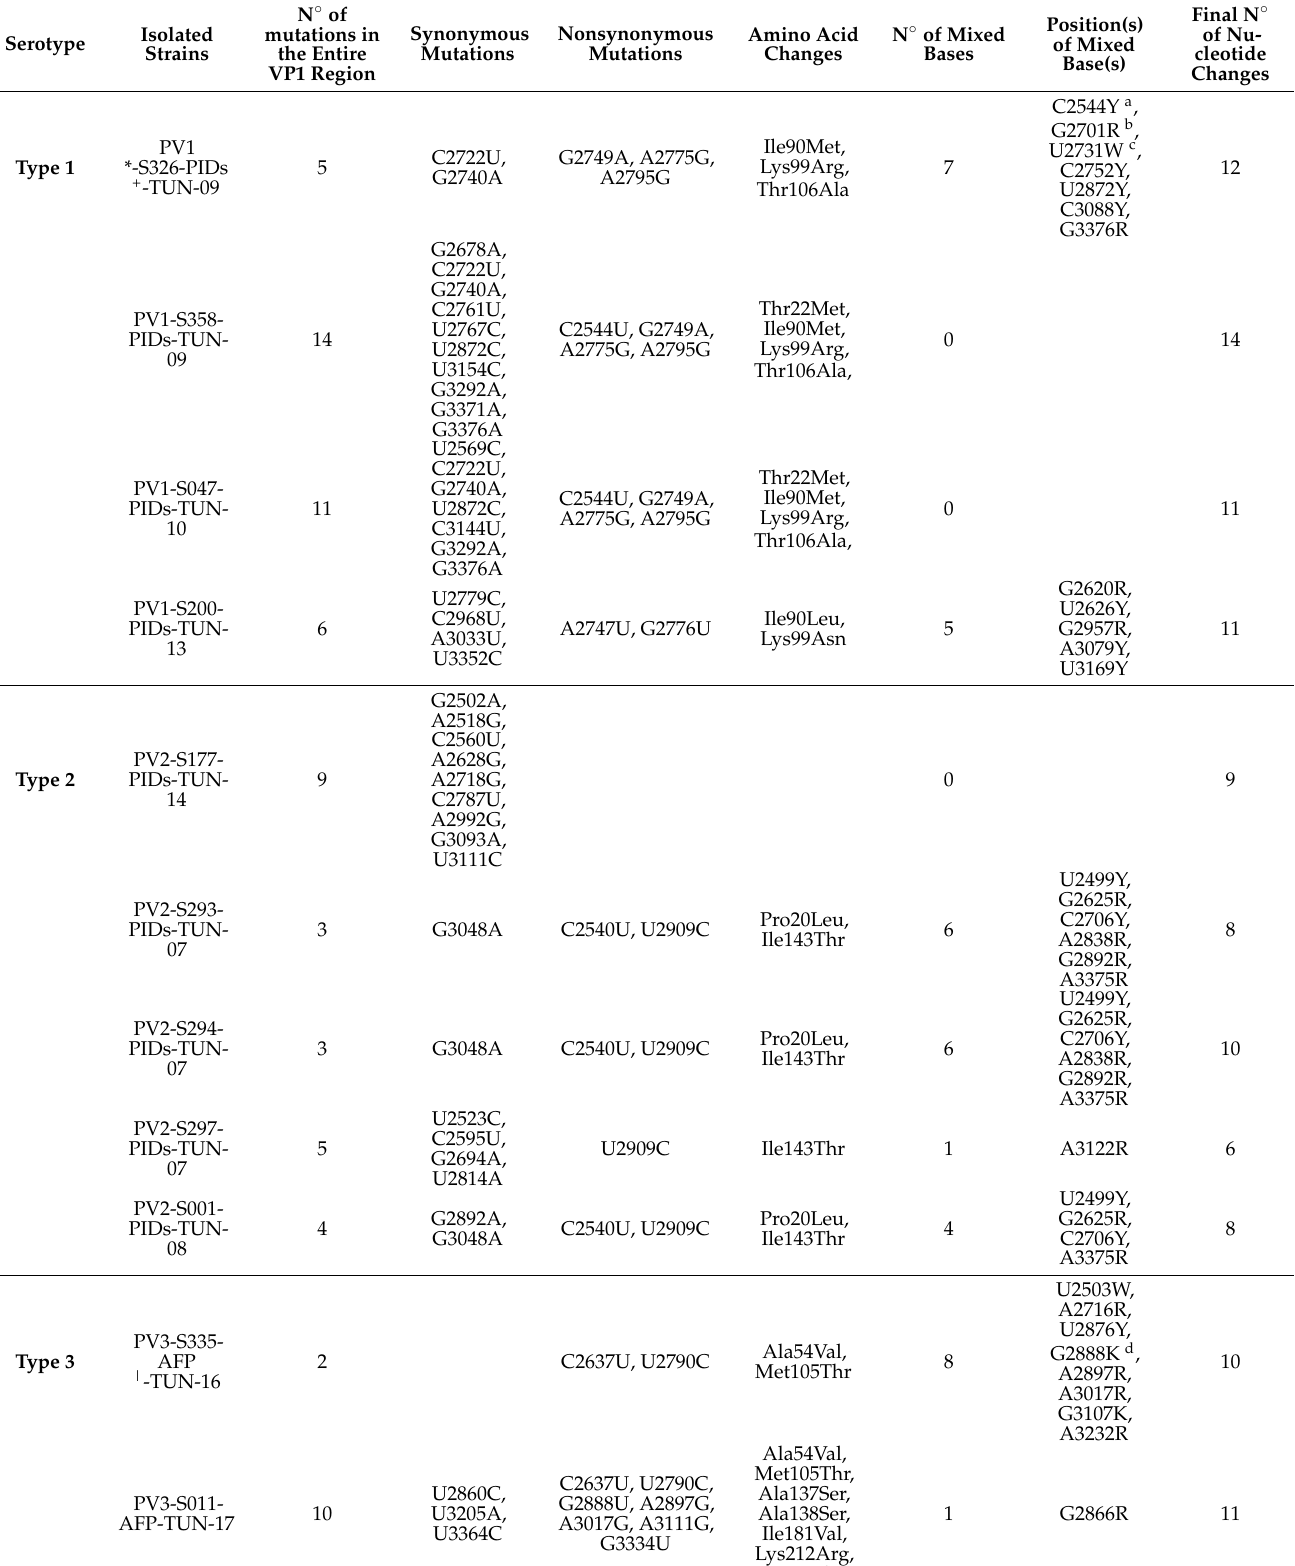
Table 4. Nucleotide and amino acid changes in the entire VP1 gene of vaccine-derived polioviruses (VDPVs) identified in comparison with Sabin